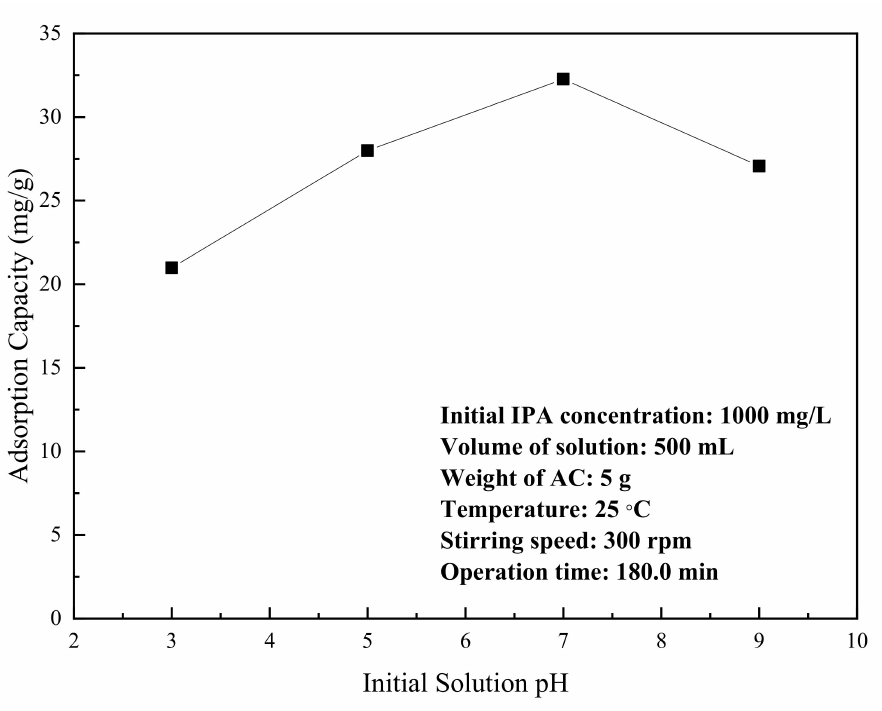
Figure 4. The e ff ect of initial solution pH on the adsorption capacity by activated